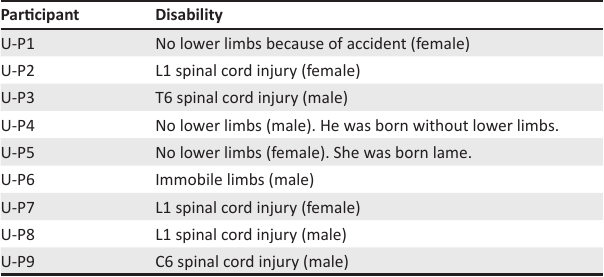
TABLE 2: Characteristics of participants in